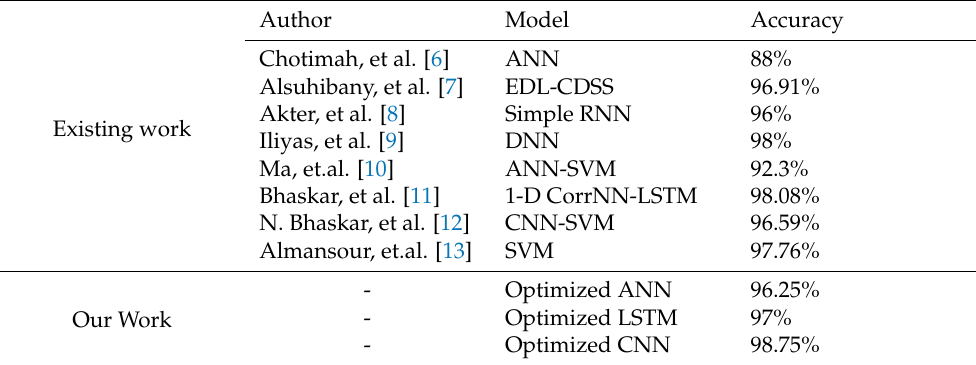
Table 6. Comparison of proposed model with existing work.